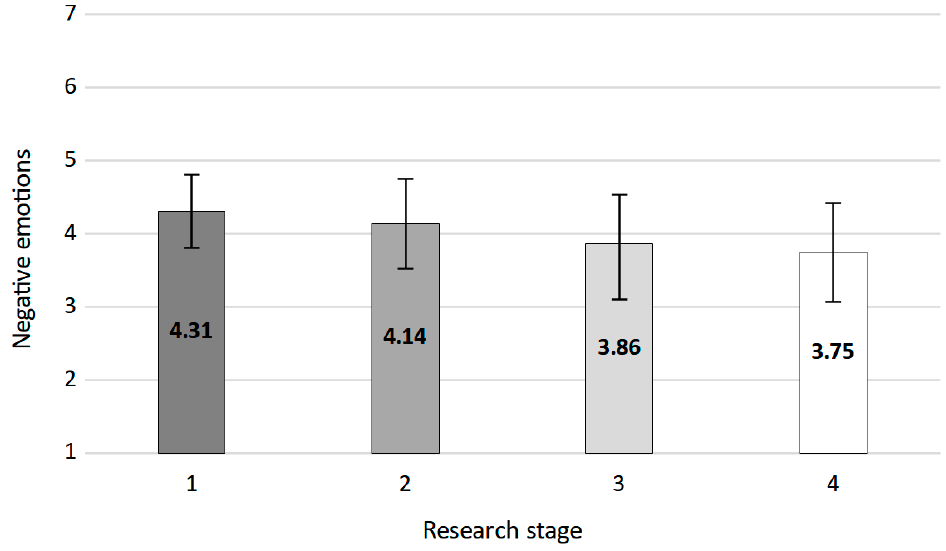
Figure 2. Intensity of negative emotions in four consecutive research stages. Error bars present standard deviations.